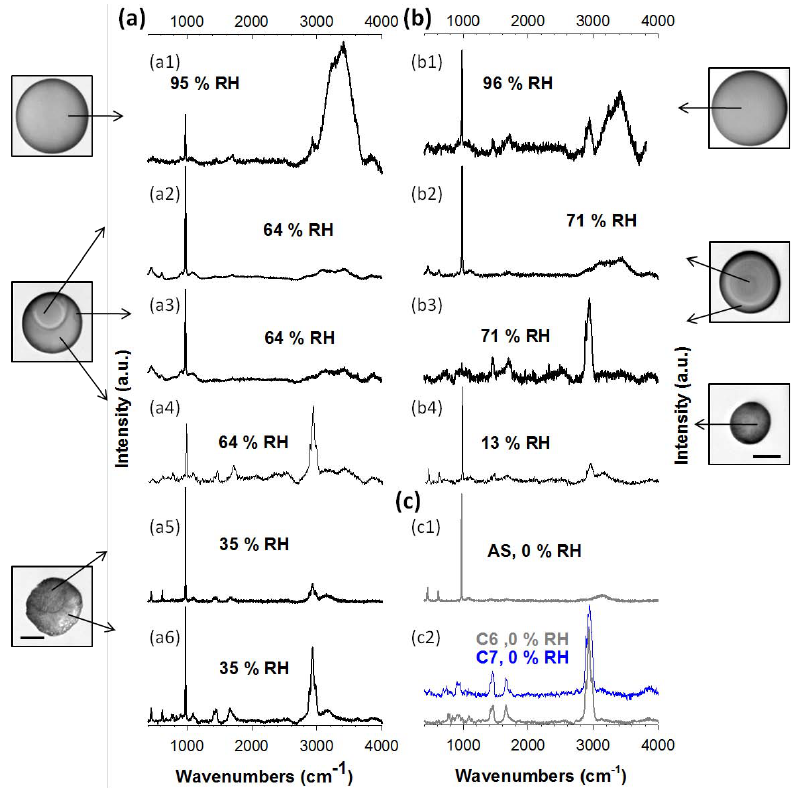
Fig. 3. Raman spectra and microscopic images of (a) C6/AS/H 2 O and (b) C7/AS/H 2 O particles with OIR=1:1 at different RH. Reference spectra are included for AS (c1) and for the pure C6 and C7 organic mixtures (c2). Size bars in the microscopic images are 20µm. at 46.3 % ( t = 238 min). This value is above the